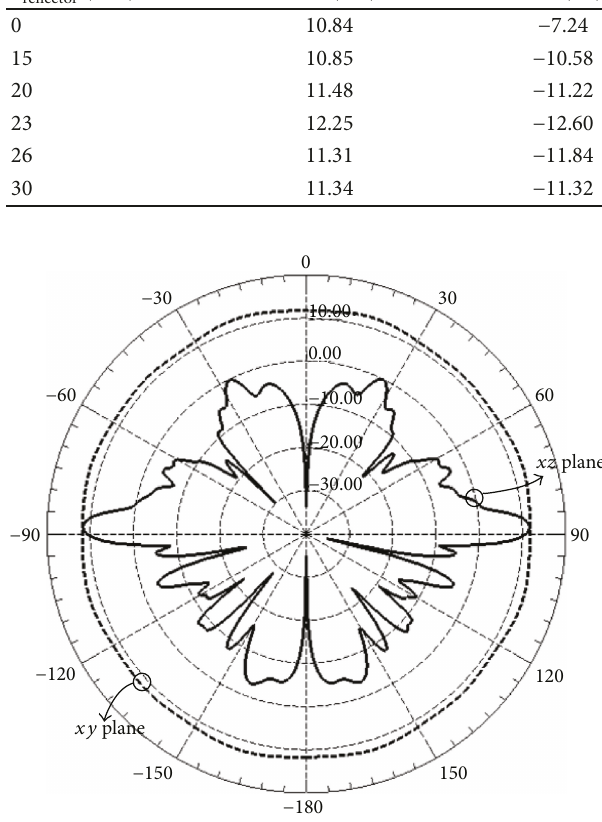
Figure 5: Radiation pattern, in dBi, of the omnidirectional ring- based SWAA at 28 GHz.